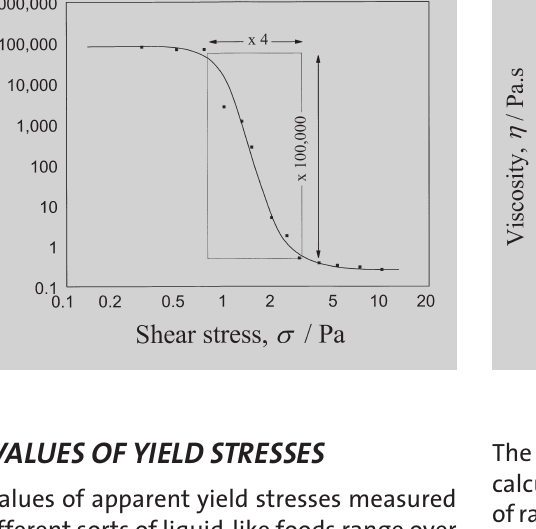
Figure 4 (left): Flow curve of 6% iron oxide in mineral oil. Figure 5 (right): Flow curve of 10% suspension Bentonite.